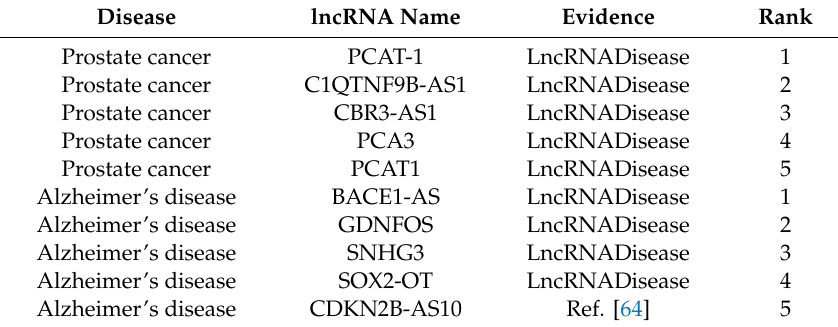
Table 2. The top five results predicted for specific isolated diseases (e.g., prostate cancer and Alzheimer’s